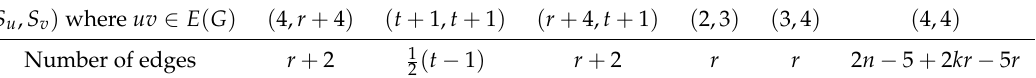
Table 12. The edge partition of the graph G for k >